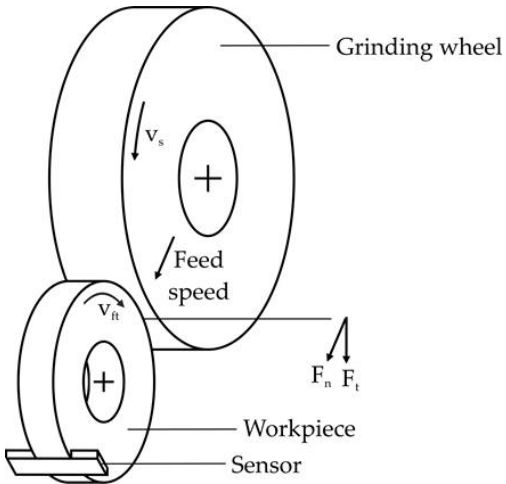
Figure 2. Schematic diagram of the cylindrical grinding